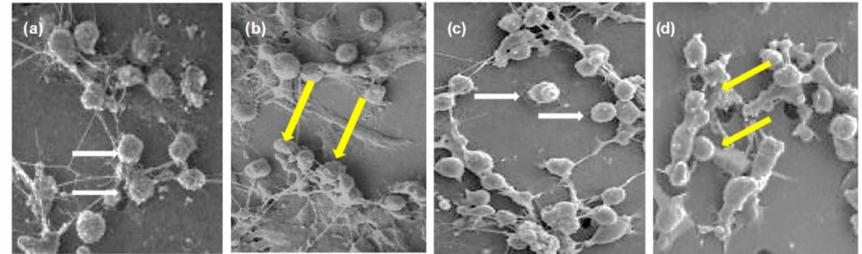
Figure 3. The cell morphologies after and before treatments using AC n -hexane as follows: ( a ) untreated MDA-MB-231, ( b ) treated MDA-MB-231, ( c ) untreated MCF7, and ( d ) treated MCF7. The white arrows indicate the normal living cell, whereas the yellow arrows indicate the cell morphology changing.